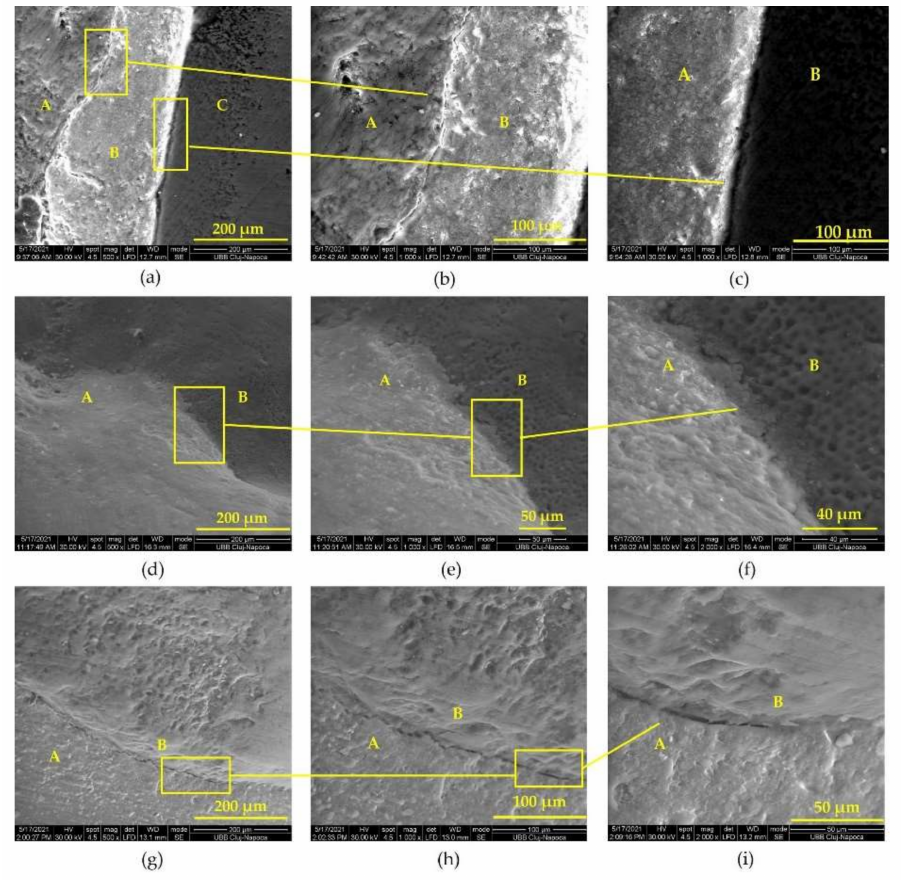
Figure 3. SEM representation of adhesion: ( a ) SEM image of the IPS e.max PRESS veneer interface area (A), adhesive cement (B), enamel area (C); ( b ) SEM image of the IPS e.max PRESS veneer (A), cement (B) interface; ( c ) SEM image of the interface adhesive cement (B), tooth enamel (C); ( d ) SEM view of ceramic inlay (A), tooth dentin (B), interface × 500; ( e ) SEM view of ceramic inlay (A), tooth dentin (B), interface × 1000; ( f ) SEM view of ceramic inlay (A), tooth dentin (B), interface × 2000; ( g ) SEM view of tooth enamel (A), ceramic crown (B), interface × 500; ( h ) SEM view of tooth enamel (A), ceramic crown (B), interface × 1000; ( i ) SEM view of tooth enamel (A), ceramic crown (B), interface ×